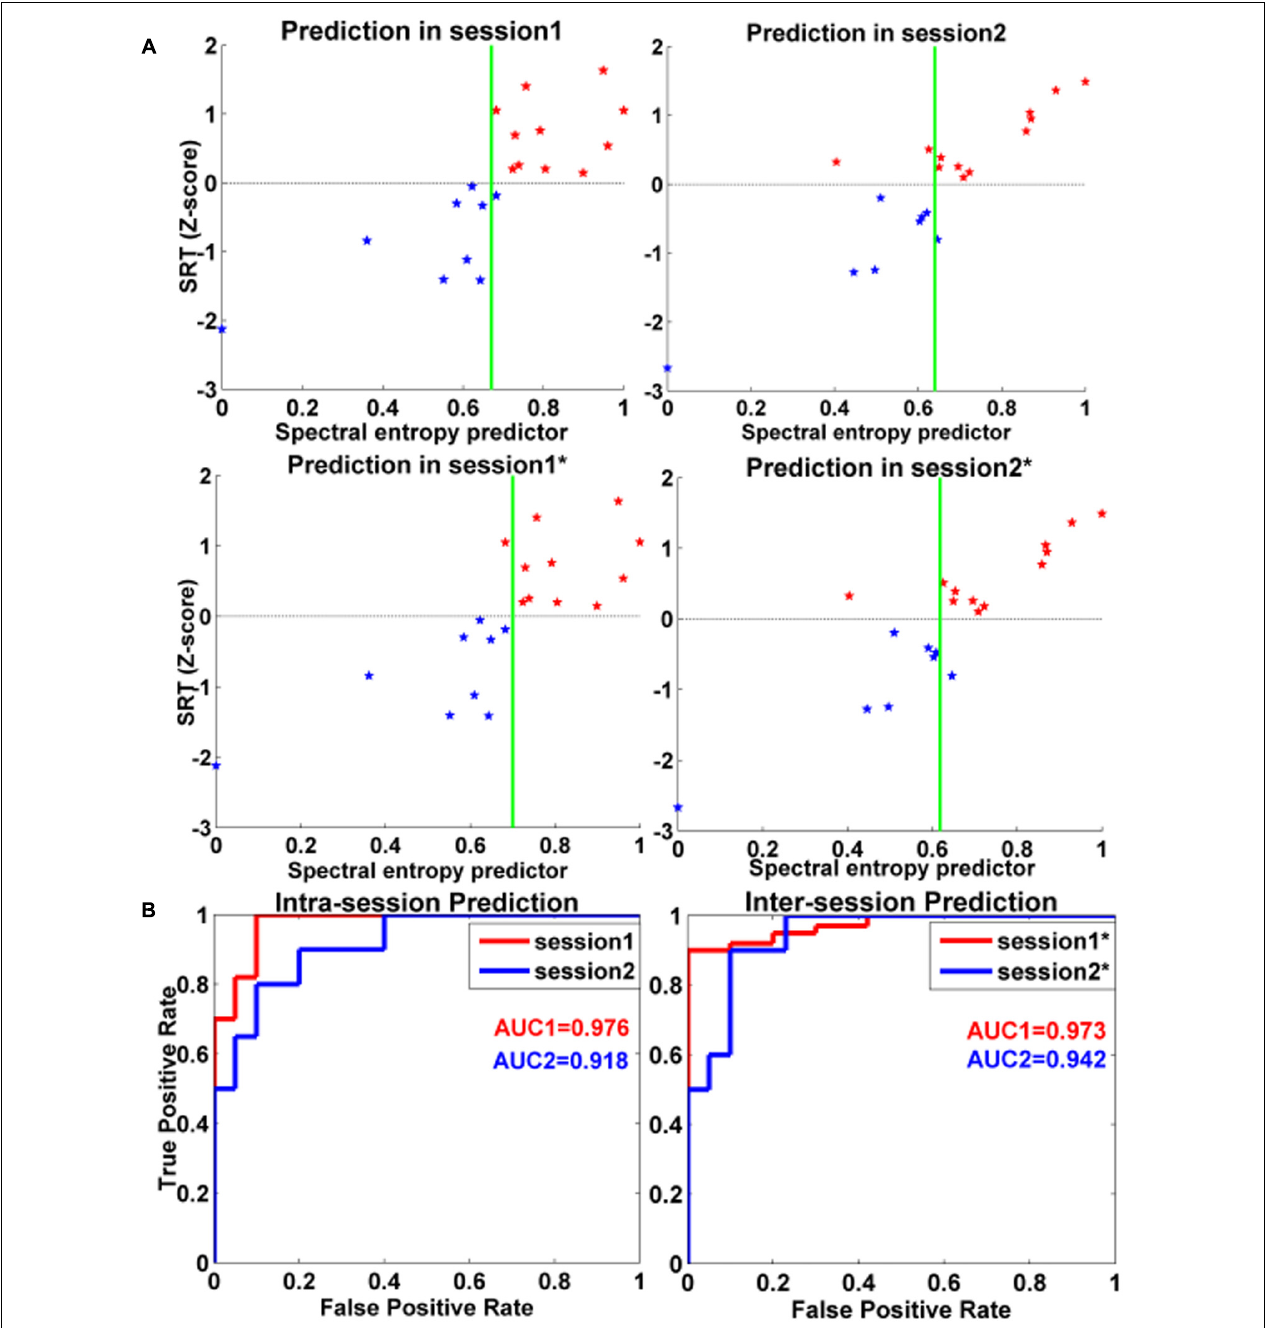
FIGURE 4 | Intra- and inter-session classifications for distinguishing high-performance and low-performance groups. (A) Classification plot for intra-session and inter-session. The red star denoted the high-performance group, and the blue star denoted the low-performance group. The green line was the classification boundaries. (B) ROC curves for spectral entropy predictors for intra-session and inter-session in classifying the two different performance groups in WM tasks. The session 1 with asterisk ( ∗ ) denoted the classification results of session 1 with WM data in session 2 as training samples. The session 2 with asterisk ( ∗ ) denoted the classification results of session 2 with WM data in session 1 as training samples. The abscissa represented the false positive rate, and the ordinate denoted the true positive rate. The red line denoted the ROC curves of session 1, and the blue line represented the ROC curves of session 2. AUC: area under curve.